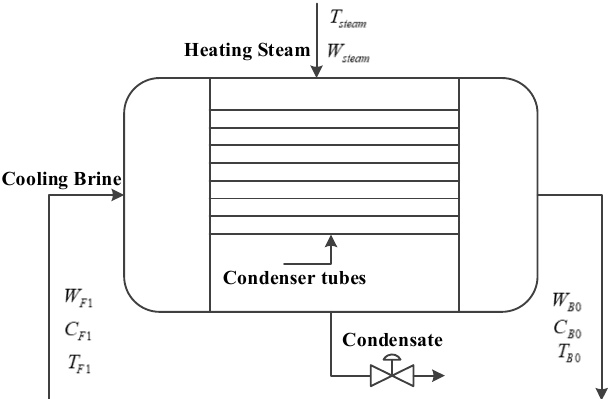
Figure 2. Structure chart of the brine heater.